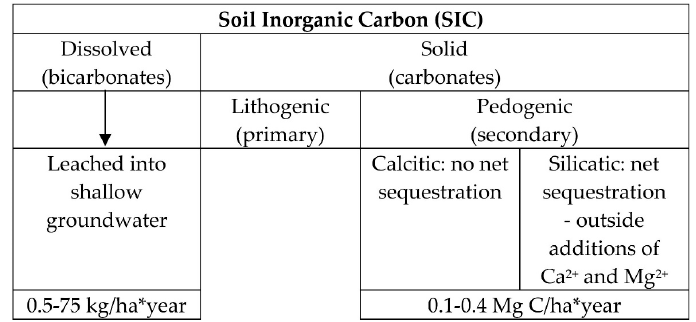
Figure 1. Types of soil inorganic (SIC) with numerical values of carbon sequestration in various soils (adapted from Lal et al. 2016 [7]).